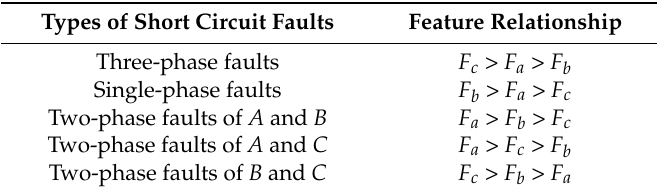
Table 2. Relationship between the fault classes and the IFBD